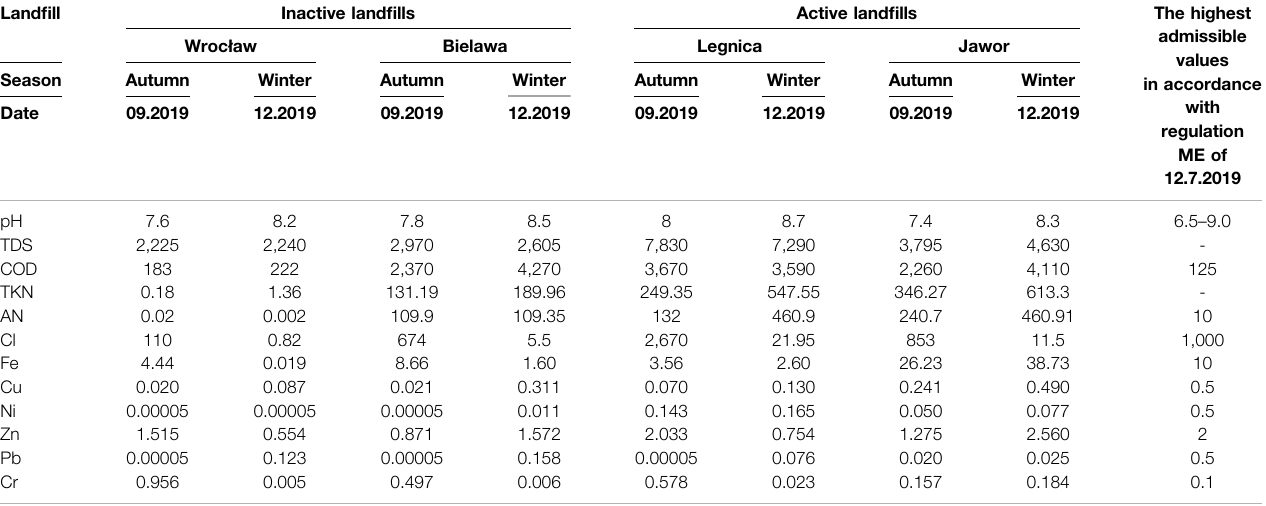
TABLE 1 | Characteristics of analyzed land fi ll leachates Land fi ll Inactive land fi